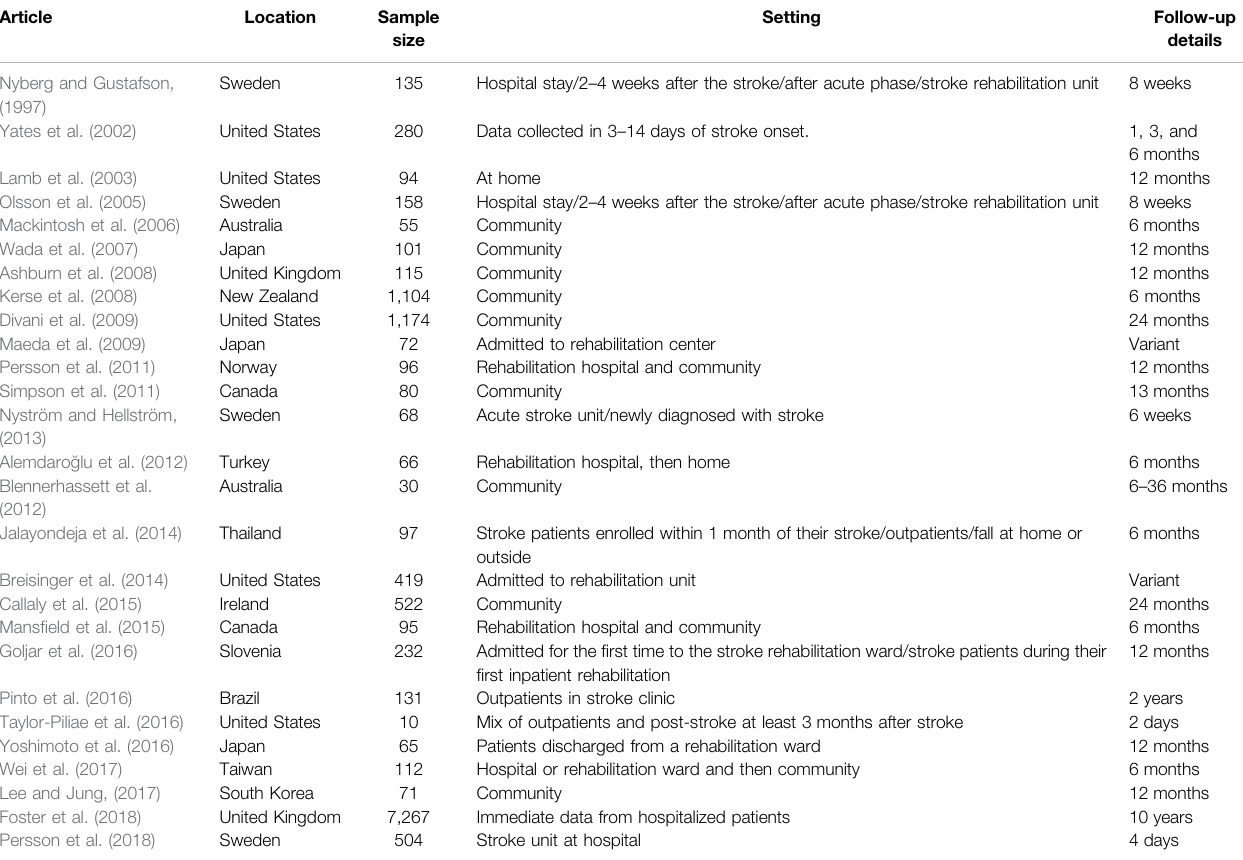
TABLE 1 | The characteristics of the reviewed